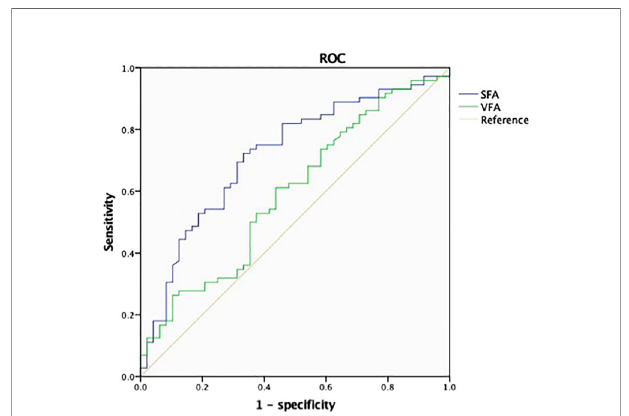
FIGURE 1 | Receiver operating characteristic (ROC) analysis and area under the curve (AUC) for the predictors of the occurrence of stone episode. The AUC values of subcutaneous fat area (SFA) and (visceral fat area) VFA were 0.718 and 0.594 with 95% con fi dence interval (CI) of 0.624 – 0.812 and 0.490 – 0.698, respectively. The cutoff point of SFA was 97 cm 2 and that of VFA was 174 cm 2 . ROC analysis was performed for the occurrence of stone episode based on sensitivity of 72.2%, speci fi city of 66.7%, and the Youden index of 0.389 for SFA and sensitivity of 61.1%, speci fi city of 56.2%, and the Youden index of 0.173 for